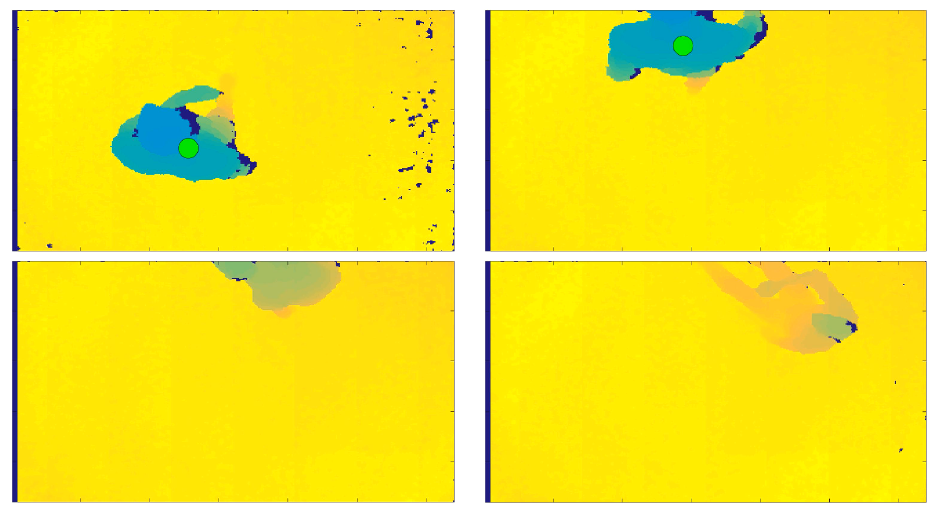
Figure 5. Fall phase of the FBELFRWK sequence simulated by ES 14, where the person entered the sensor coverage area but then left the scene before